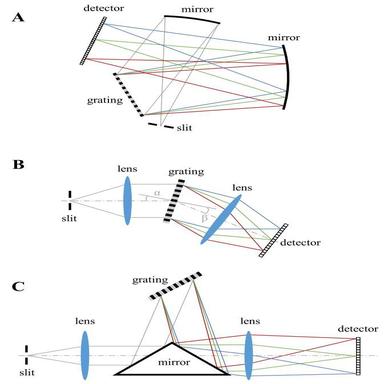
Selection of different spectrometer designs from commercially available spectrometers: A) asymmetrically crossed Czerny-Turner design (e.g. Ocean Insight QEPro), B) Transmission VHG (e.g. Andor HoloSpec), C) Renishaw InVia Raman spectrometer.